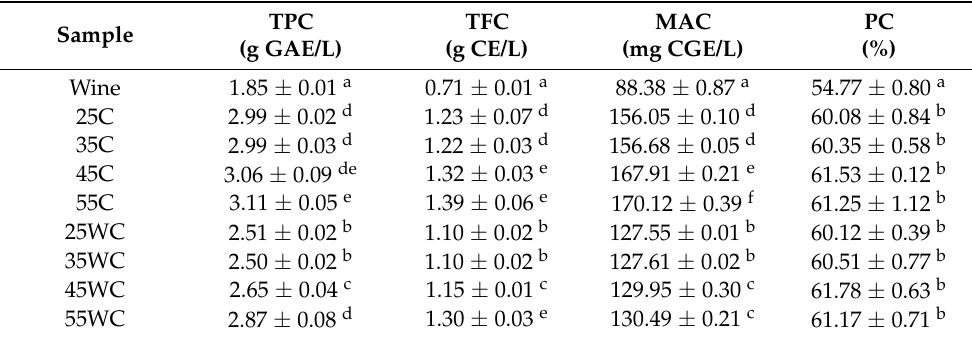
Table 2. Total polyphenol content (TPC), total flavonoid content (TFC), monomeric anthocyanin content (MAC), and polymeric color (PC) of an the initial Cabernet Sauvignon wine variety and retentates obtained by reverse osmosis at 25, 35, 45, and 55 bar with cooling (C) and without cooling (WC).